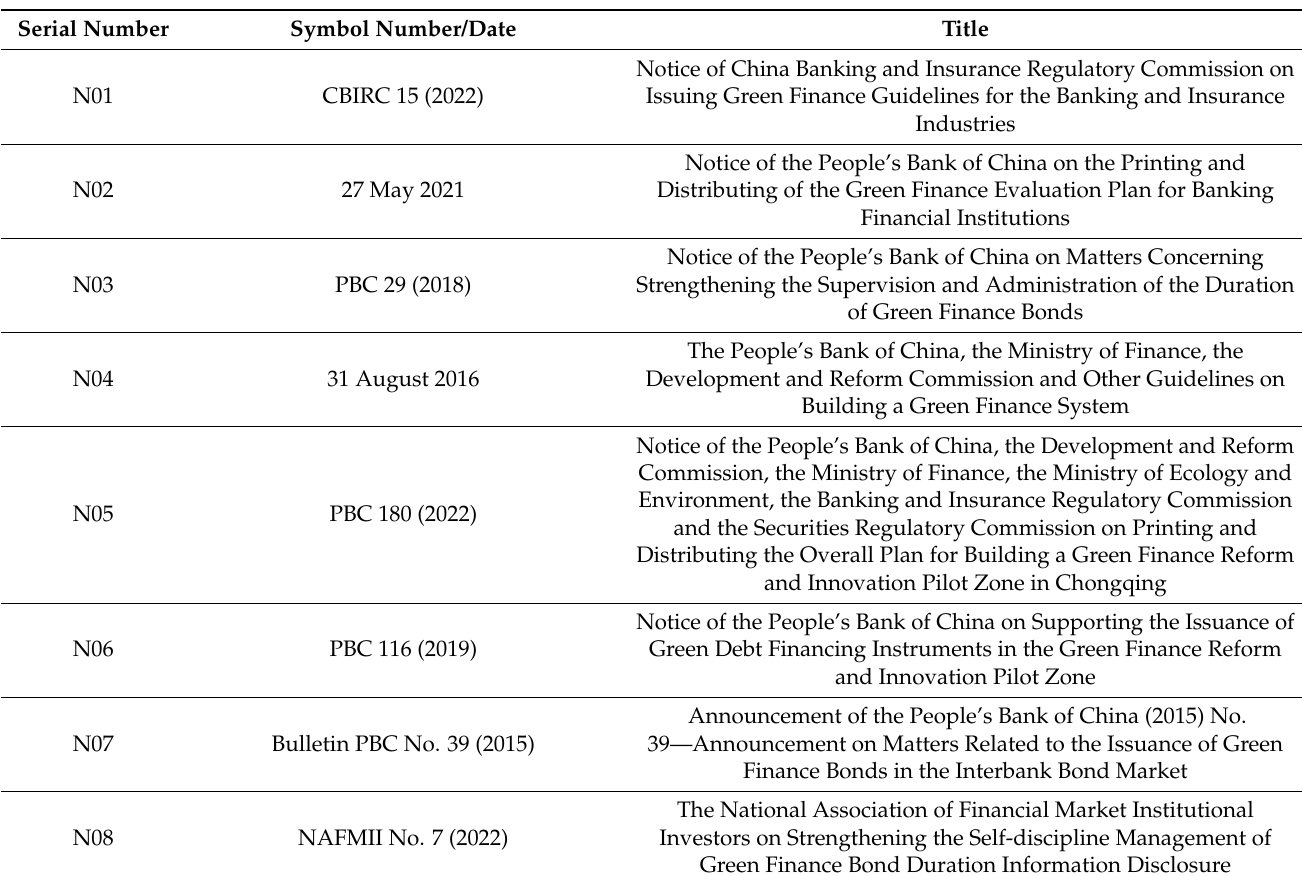
Table 6. List of legal and policy